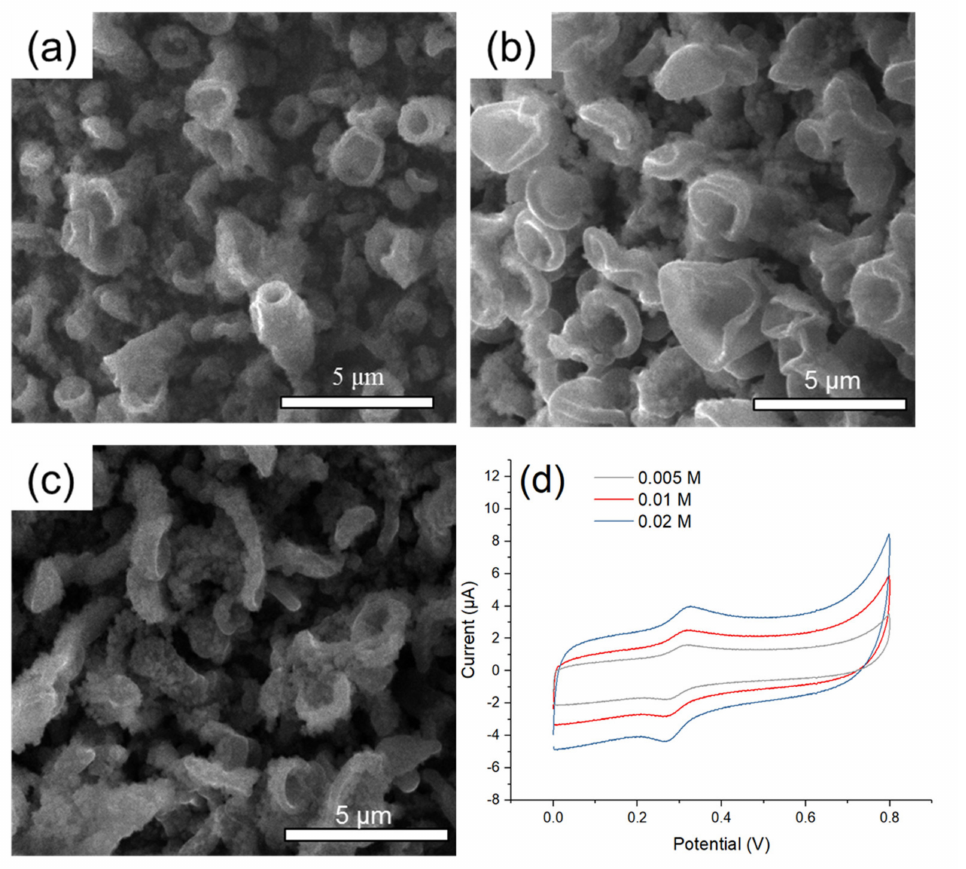
Figure 7. The SEM images of MOF525 / PEM composites synthesized under: ( a ) 0.005 M; ( b ) 0.01 M; ( c ) 0.02 M TBAP solution at − 42.5 ◦ C; and ( d ) the CV traces of MOF525 / PEM composites modified microelectrode synthesized under various TBAP concentrations at − 42.5 ◦